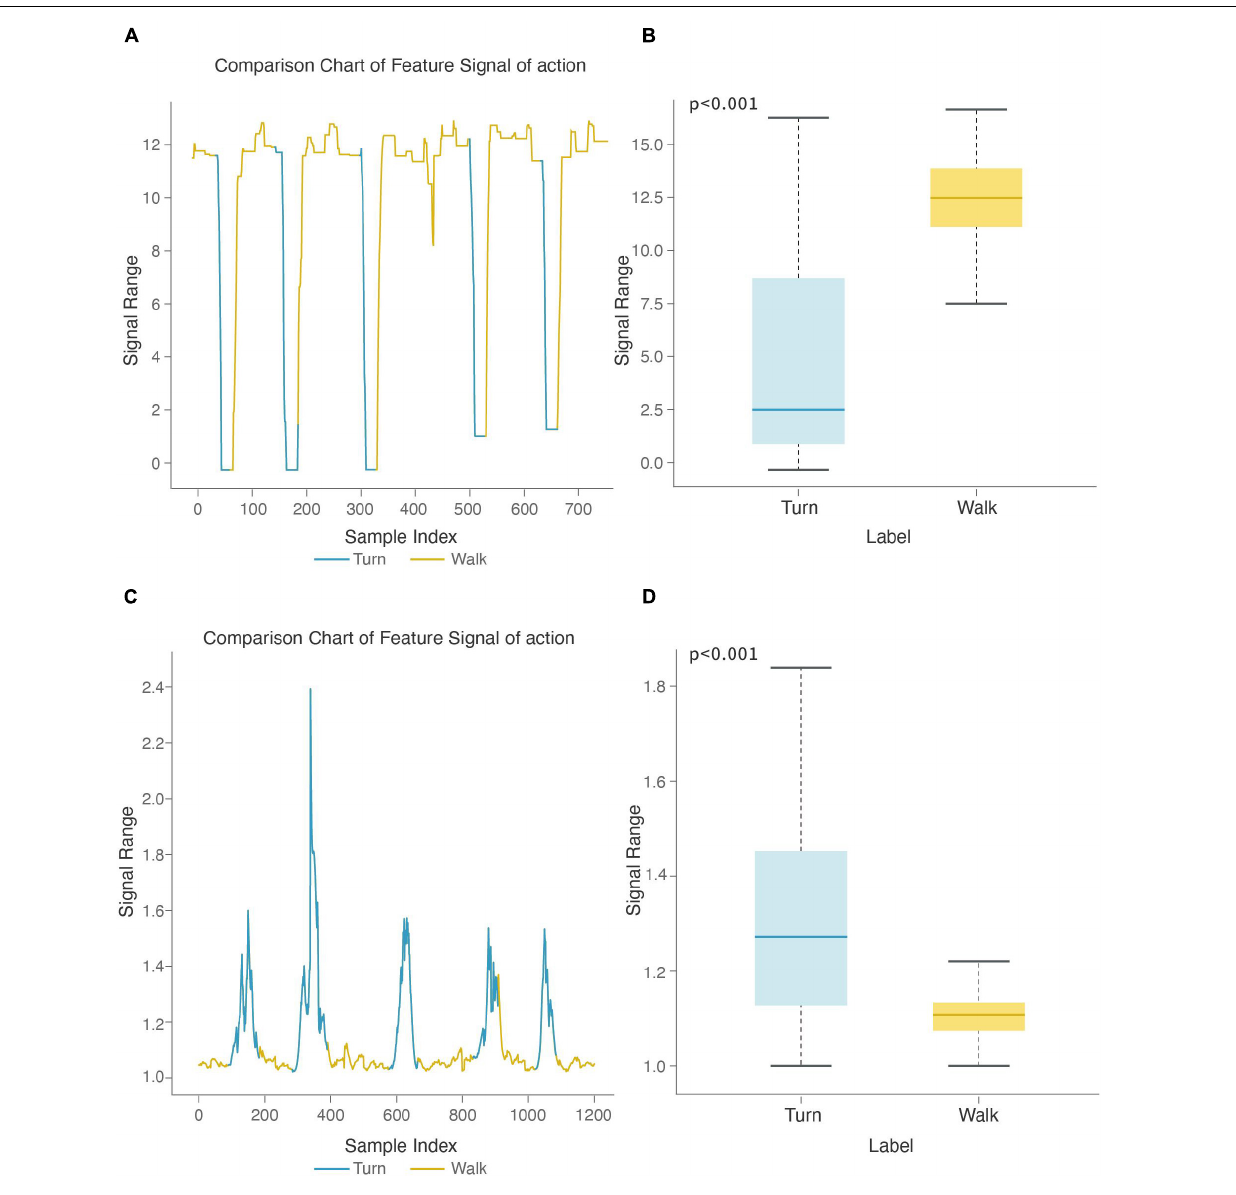
well, and the P values also passed the significance test ( p =